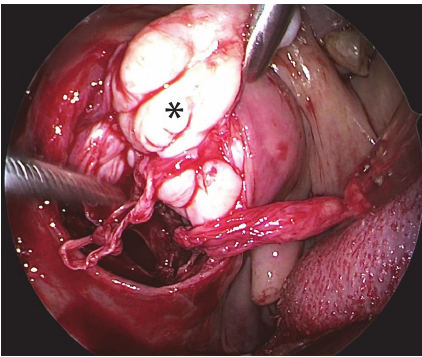
Figure 1: Endoscopic view showing the tumor ( ∗ ) which is exposed after giving submucosal incision and dissecting thefibers of superior constrictor.